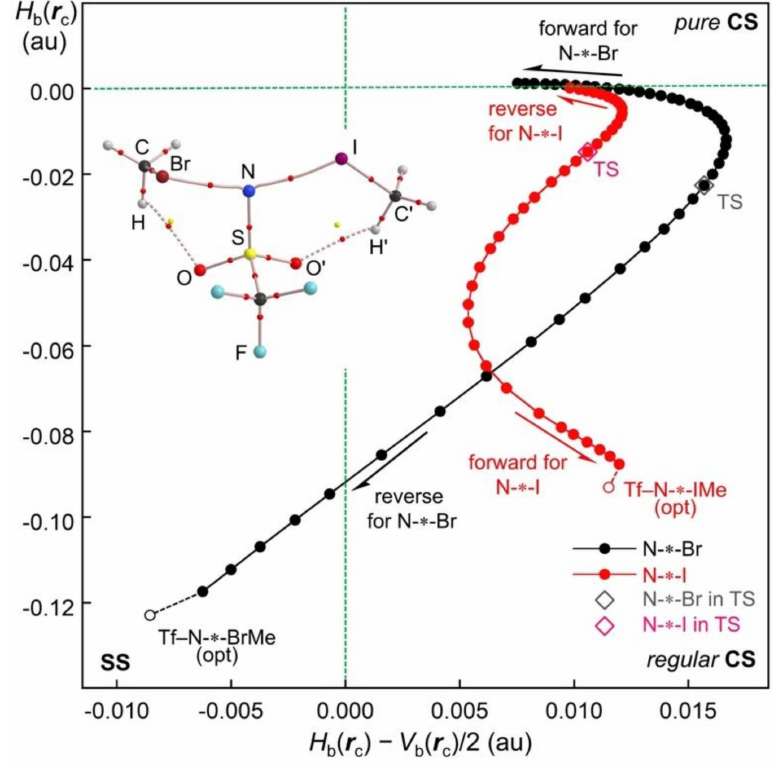
Figure 10. Plots of H b ( r c ) versus H b ( r c ) − V b ( r c )/2 for a wide range of interaction distances around TS [MeI- ∗ -N(Tf)- ∗ -BrMe], calculated MP2/BSS-C’. The perturbed structures are generated with